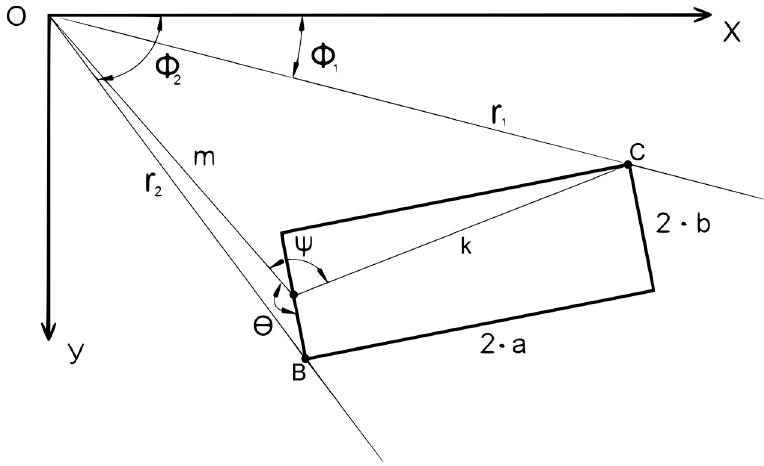
Figure 7. Truck rotation diagram in the rectangular coordinate system.